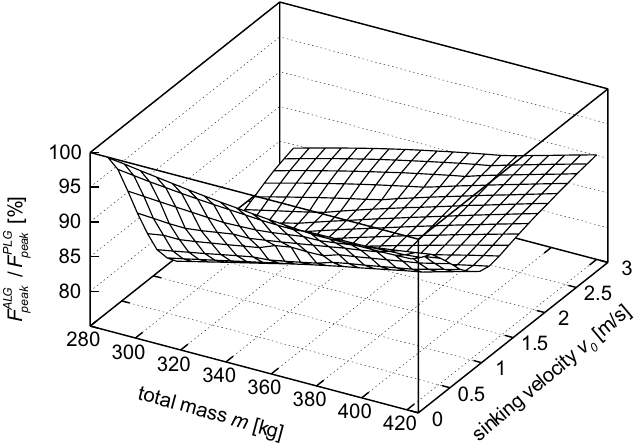
Fig. 10. ALG compared to PLG, relative improvement: Computed ratio of the peak strut forces in the optimally controlled ALG and PLG at the same landing conditions, in dependence on the total mass m and sinking velocity v 0 .